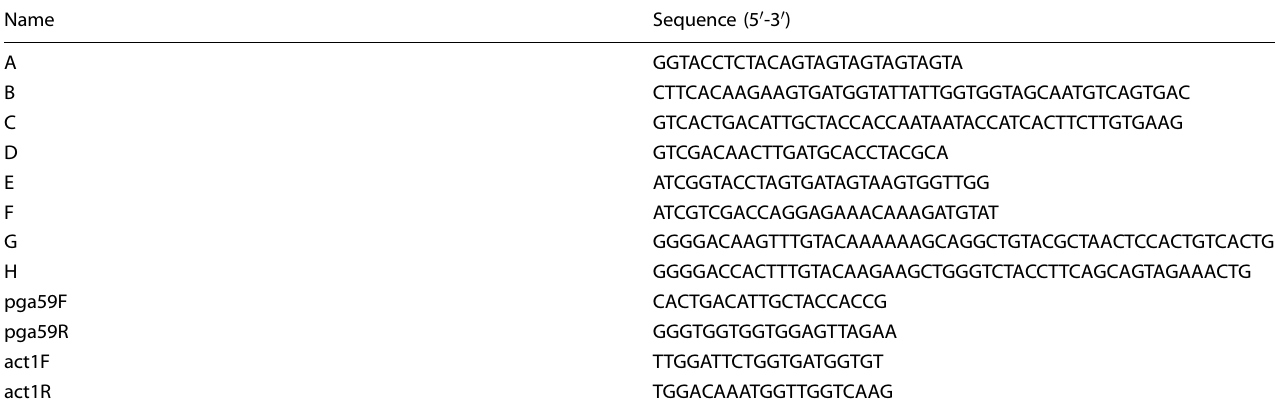
Table 2. Oligonucleotides used in this